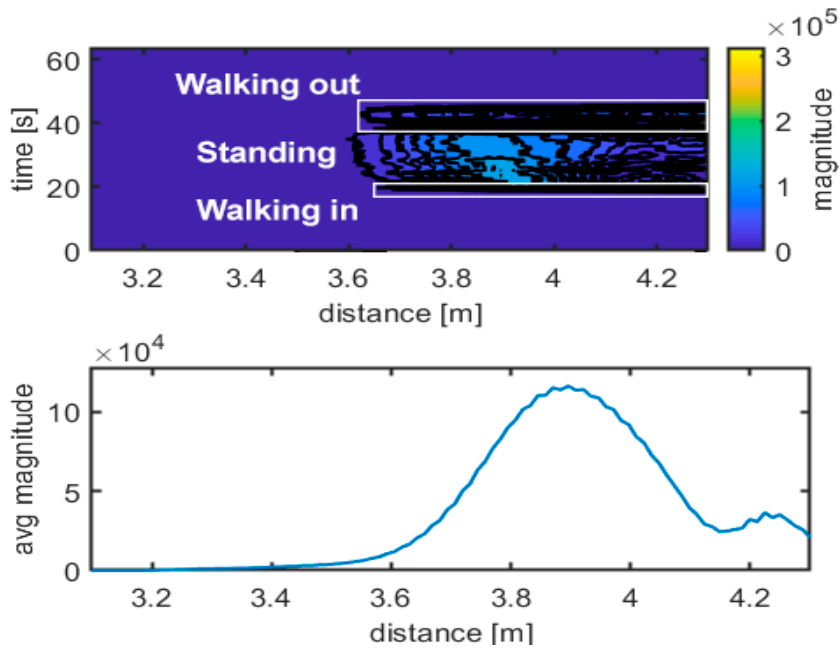
Figure 7. Movement identification. Experimental results: walking in–standing frontside–walking out. Magnitude unit is µV.